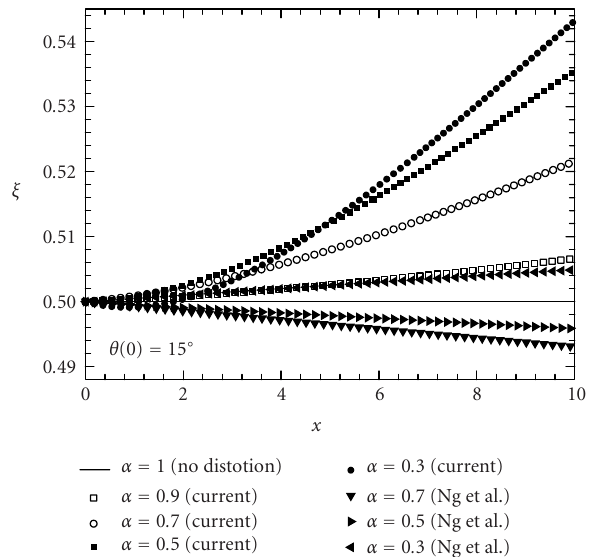
Figure 5: The inlet distortion propagates along axial direction with di ff erent inlet distortion